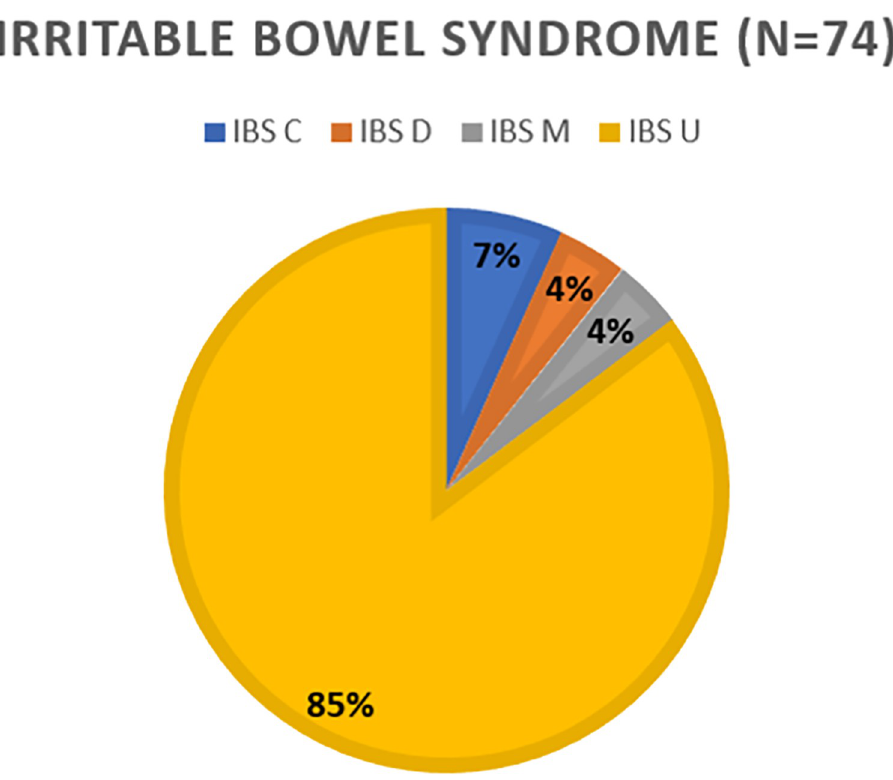
Fig 1. Sub classification of irritable bowel syndrome.